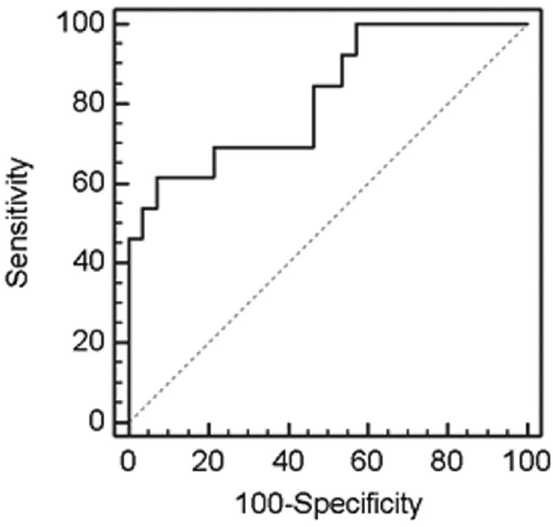
Figure 5. ROC curve for the maximum/minimum sCD26 ratio contrasting disease-free individuals and patients with local or distant recurrence. The corresponding AUC is provided in the text.